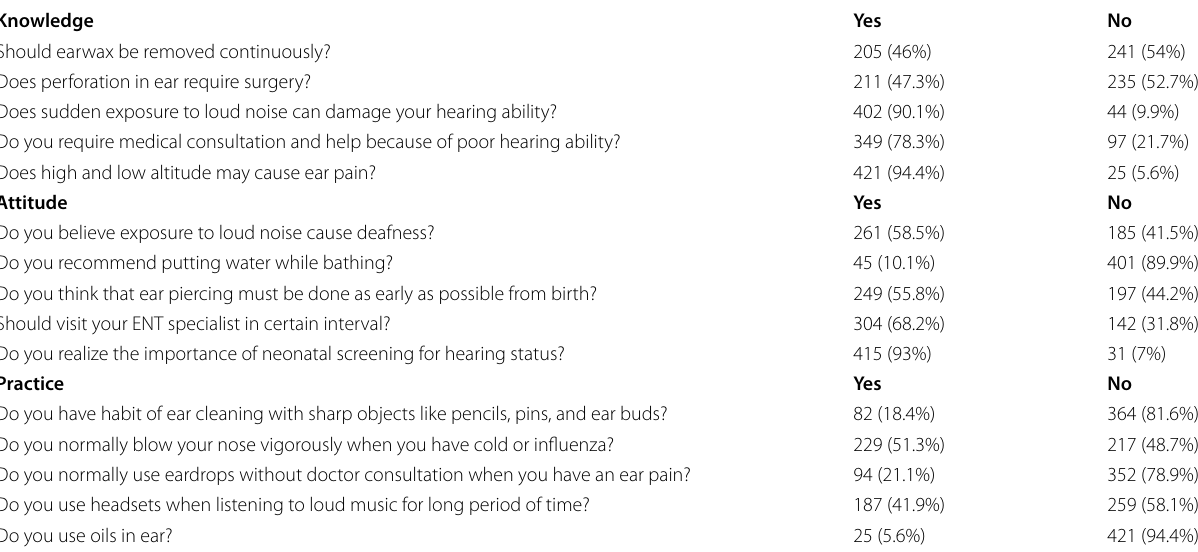
Table 2 Knowledge, attitude, and practice of ear care